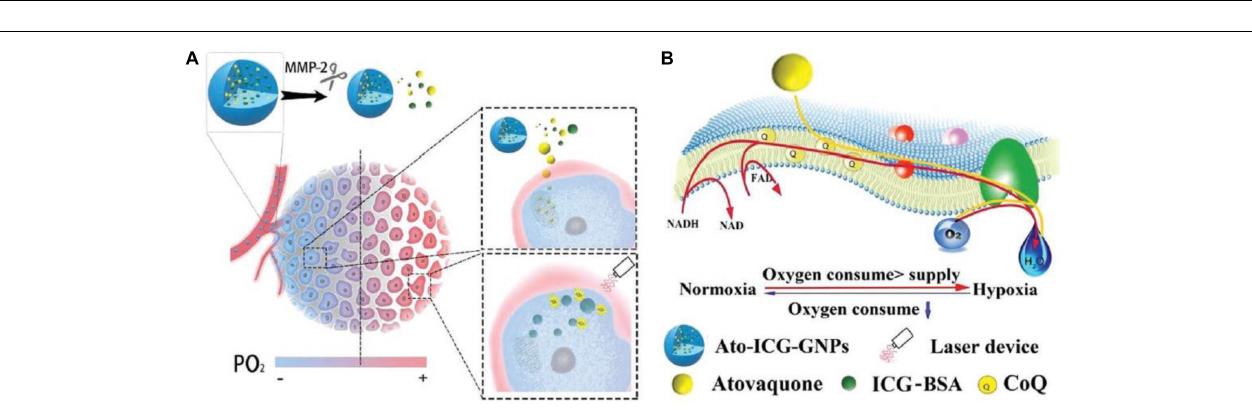
FIGURE 2 | Elucidation of the dual strategy of combination of size shrinkable nanoparticles with collagen depletion by losartan. (A) Losartan treatment reduced the collagen level of xenografted tumor, leading to deeper penetration of DOX-loaded nanogold onto gelatin nanoparticles. (B) MMP-2-triggered size shrunk and low-pH-induced DOX release in tumor (reproduced with permission from Cun et al. (2016). Copyright 2016 Elsevier).